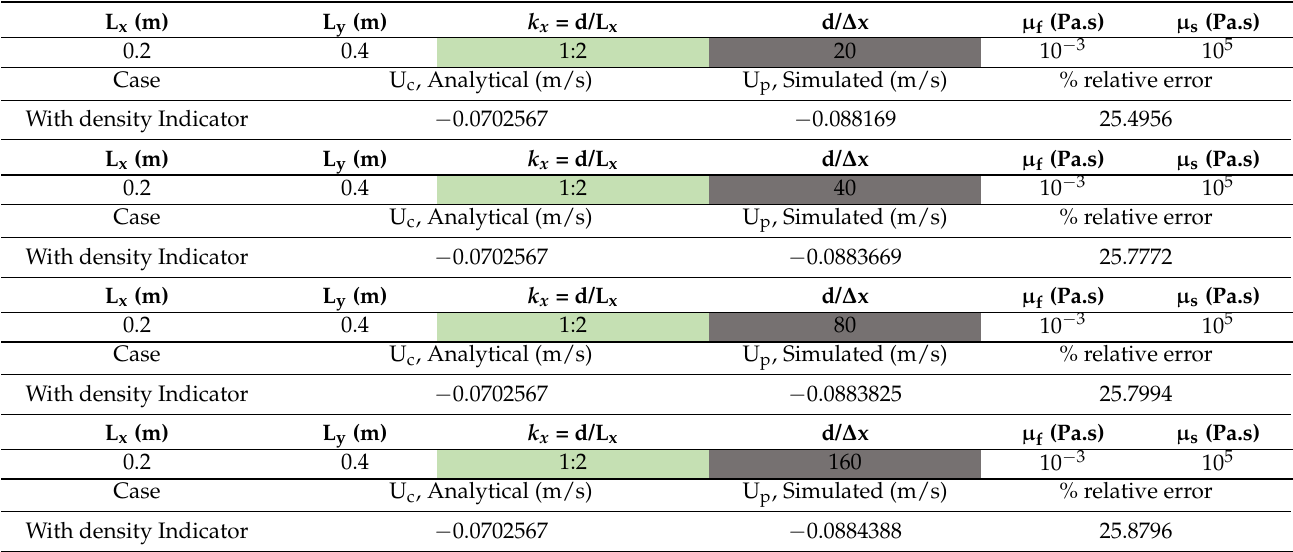
Table A5. Effect of mesh